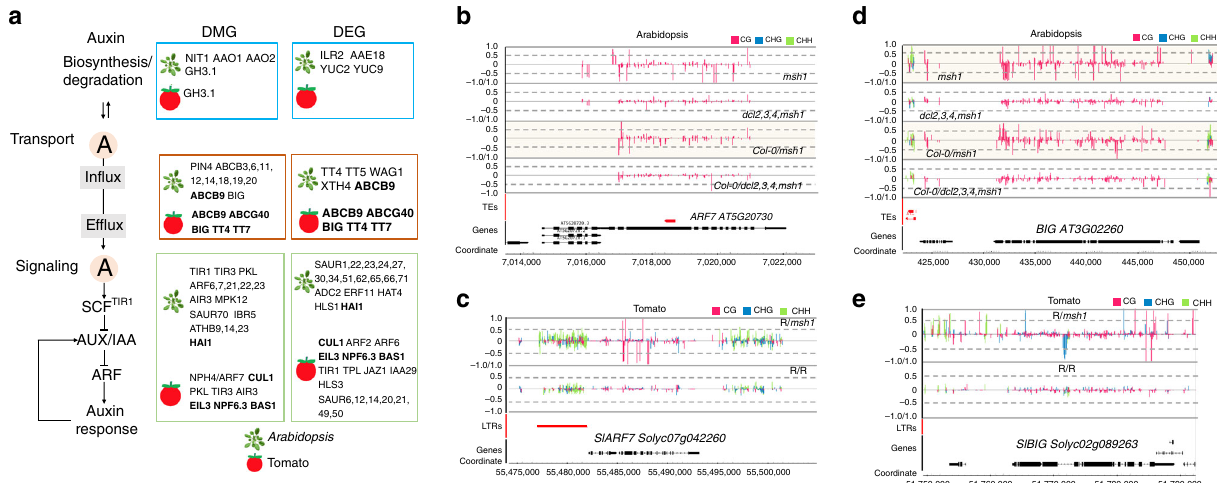
Fig. 7 Auxin pathway genes identi fi ed in association with the HEG effect. a Auxin pathway DMGs and DEGs identi fi ed in the Arabidopsis Col-0/ msh1 vs. Col-0/ dcl2,3,4,msh1 graft progeny ( fi rst generation) comparison and tomato R/R vs. R/ msh1 graft progeny ( fi rst generation) comparison. Genes within the blue box are auxin biosynthesis/degradation related, in the red box are transport-related, and in the green box are signaling-related. Genes identi fi ed as both DEGs and DMGs are shown in bold. Single cytosine methylation level changes in Arabidopsis mutants msh1 and dcl2,3,4,msh1 , and graft progenies from Col-0/ msh1 and Col-0/ dcl2,3,4,msh1 ( fi rst generation) at genes b ARF7 (AT5G20730) and d BIG (AT3G02260) loci. Single cytosine methylation level changes in the tomato Rutgers/Rutgers (R/R) and Rutgers/ MSH1 -RNAi (R/ msh1 ) graft progeny ( fi rst generation) at the c SlARF7 (Solyc07g042260) and e SlBIG (Solyc02g089263) loci. Methylation level differences at each cytosine were computed by subtracting average methylation level of reference plants from the methylation level of each individual sample. For msh1 and dcl2,3,4,msh1 mutants, dcl2,3,4,msh1 plants were used as reference. For Col-0/ msh1 and Col-0/ dcl2,3,4,msh1 graft progeny, Col-0/ dcl2,3,4,msh1 graft progeny plants were used as reference. Only one plant from each genotype was selected as representative; the pattern differs slightly for different individuals due to fl uctuation in methylation. Integrated Genome Browser (version 9.0.2) was used to generate fi gure. Panel a was made by authors based on data from this study and information adapted from Zubo and Schaller 77